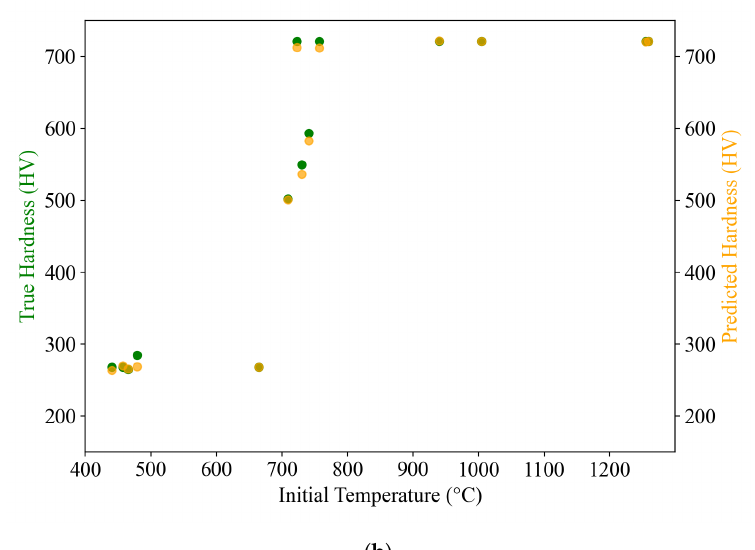
Figure 14. Comparison between the true and predicted hardness of the global dataset: ( a ) training dataset with the predicted hardness (blue) over the ground truth (red). ( b ) testing dataset with the predicted hardness (yellow) over the ground truth (green). Both with respect to the initial temperature of the